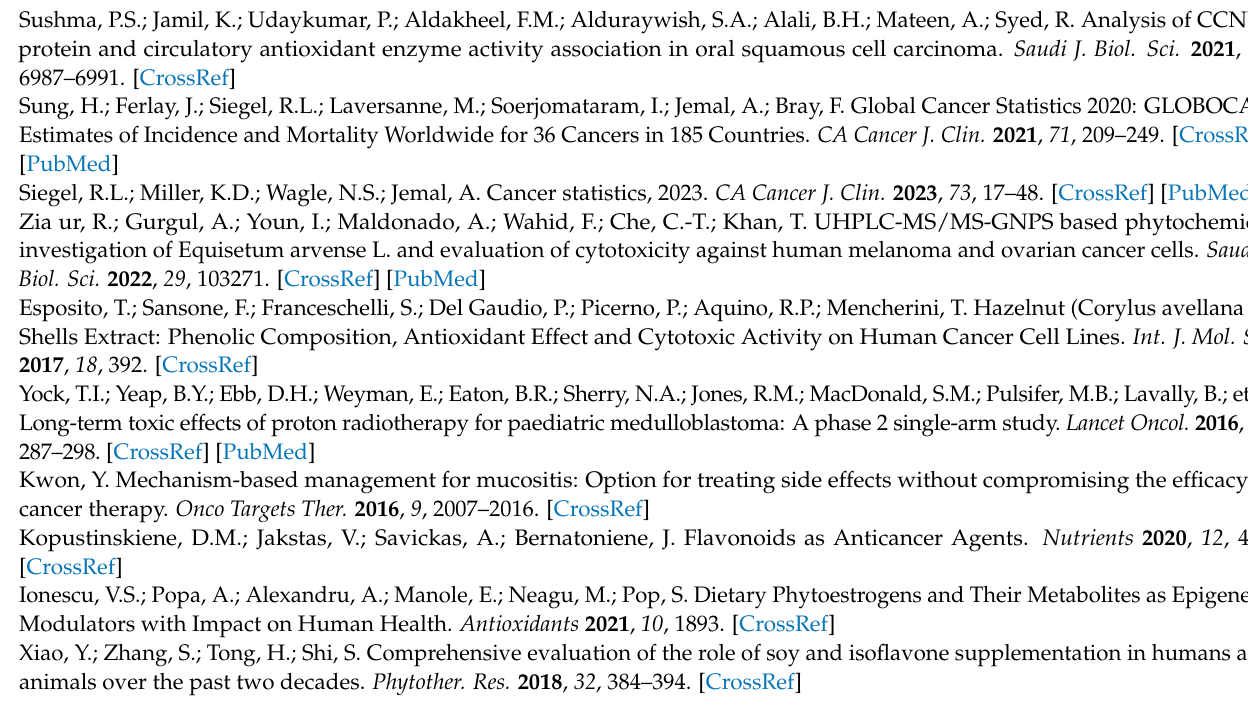
.3390/appliedchem3010009/s1, Figure S1. CID spectrum of genistin (CE = 20 eV), Figure S2. CID spectrum of genistin (CE = 40 eV), Figure S3. CID spectrum of 6- or 8- hydroxygenistein (CE = 20 eV), Figure S4. CID spectrum of 6- or 8- hydroxygenistein (CE = 40 eV), Figure S5. CID spectrum of 6- or 8- hydroxygenistein-glucoside (CE = 40 eV), Figure S6. CID spectrum of 6- or 8- hydroxygenistein- glucoside (CE = 50 eV), Figure S7. CID spectrum of tectorigenin (CE = 40 eV), Figure S8. CID spectrum of tectorigenin isomer 1 (CE = 40 eV), Figure S9. CID spectrum of tectorigenin isomer 2 (CE = 40 eV), Figure S10. CID spectrum of tectoridine (CE = 20 eV), Figure S11. CID spectrum of tectoridine (CE = 40 eV), Figure S12. CID spectrum of tectoridine (CE = 60 eV), Figure S13. CID spectrum of apigenin (CE = 20 eV), Figure S14. CID spectrum of apigenin (CE = 40 eV), Figure S15. CID spectrum of luteolin (CE = 20 eV), Figure S16. CID spectrum of luteolin (CE = 40 eV), Figure S17. CID spectrum of kaempferol (CE = 20 eV), Figure S18. CID spectrum of kaempferol (CE = 40 eV), Figure S19. CID spectrum of dihydrokaempferol (CE = 20 eV), Figure S20. CID spectrum of naringenin (CE = 20 eV), Figure S21. CID spectrum of quercetin (CE = 20 eV), Figure S22. CID spectrum of quercetin (CE = 40 eV), Table S1. Qualitative and quantitative analysis of cells stained with a mixture of AO/EB after 72 h of incubation with RC and KF extracts at a concentration of 64 µ g/mL compared to intact cells